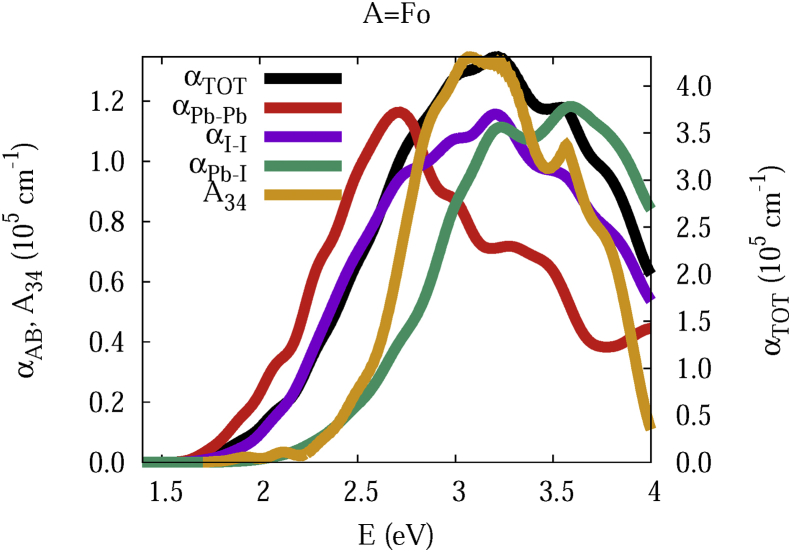
Same legend as that in Fig. 1, but for A = Fo.